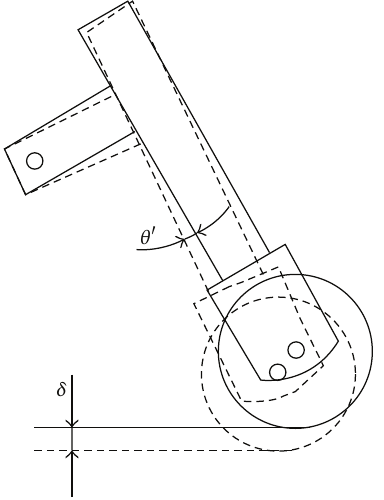
Figure 13: Motion position of the bearing wheel.